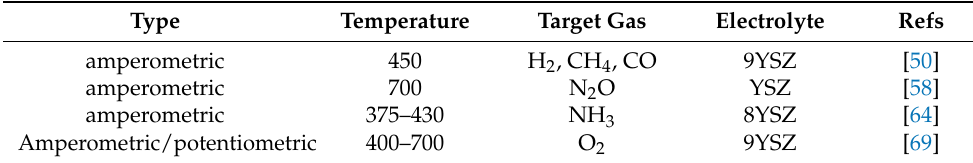
Table 2. Electrochemical gas sensors based on oxygen anion-conducting